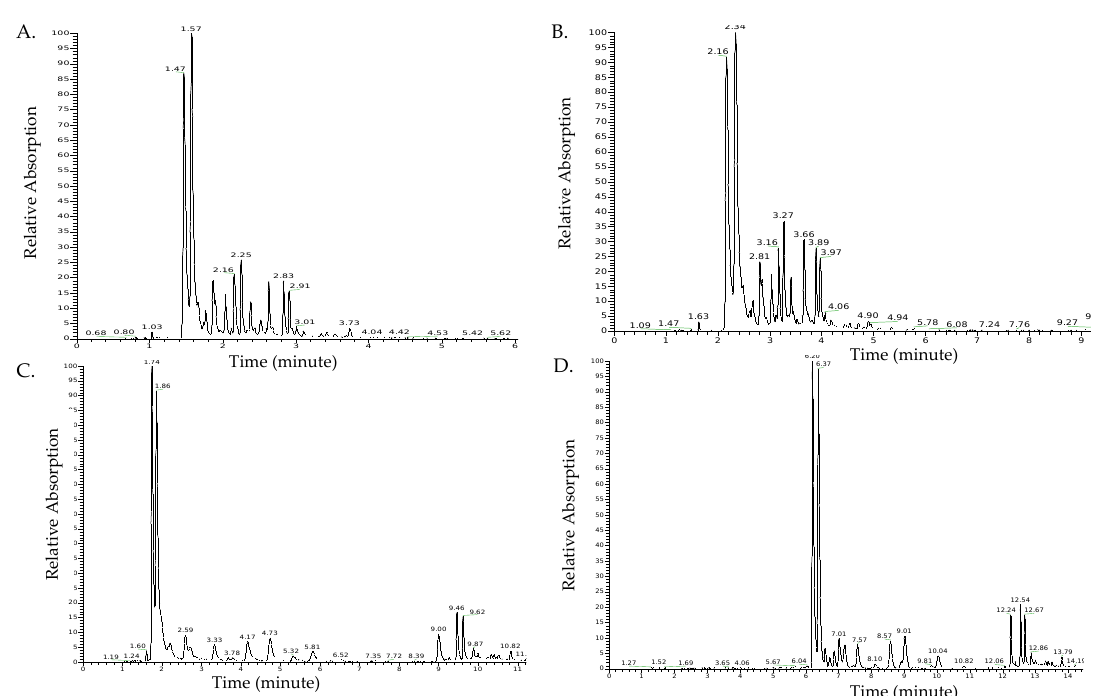
Figure 1. Chromatogram results of different ultra-high-performance liquid chromatography (UHPLC)-photodiode array (PDA) methods examining the flow rate and gradient elution time. Flow rate: ( A ) UHPLC chromatogram of 500 µL/minute flow rate, ( B ) UHPLC chromatogram of 300 µL/minute flow rate. Gradient elution time: ( C ) UHPLC chromatogram of 21 min gradient elution time, ( D ) UHPLC chromatogram of 24 min gradient elution time.